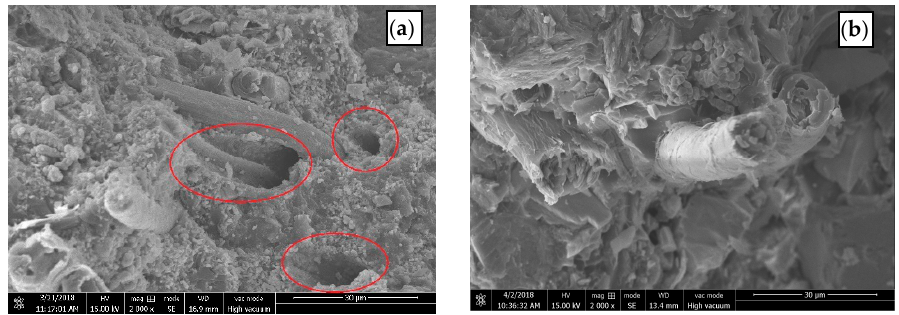
Figure 5. SEM images of the fracture morphology of samples after impact testing: ( a ) untreated; ( b ) RES-treated.